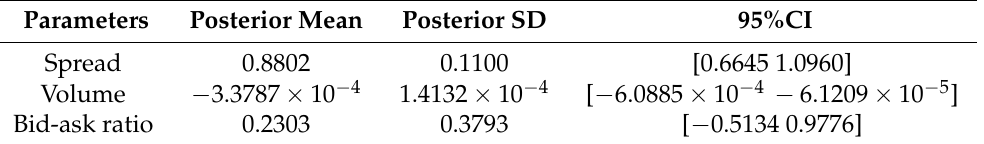
Table 18. Estimated parameters about limit order book (23 June 2016, AGH, Tokyo, Japan).